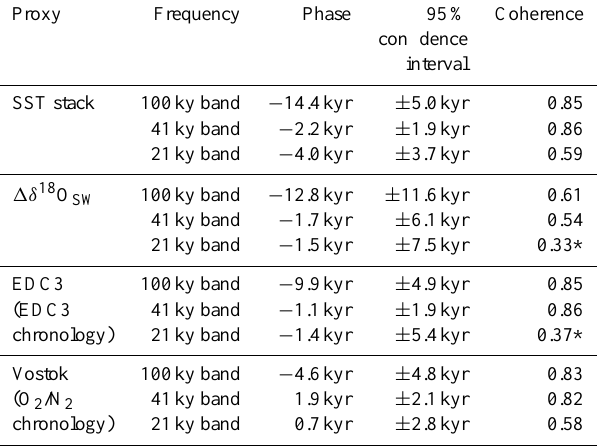
Table 1. Phase and coherence between Agulhas surface proxies and − 1 · δ 18 O benthic. A negative phase indicates that the Agul- has surface records are leading δ 18 O benthic. In addition, phase and coherence between Antarctic temperature records and Agulhas SST stack record were calculated. A negative phase indicates that Agulhas SST stack is lagging Antarctic ice core records. Note that phase and coherence between the Vostok temperature record (Suwa and Bender, 2008) and Agulhas SST stack were calculated for an overlapping period (i.e., 0–411kyrBP).